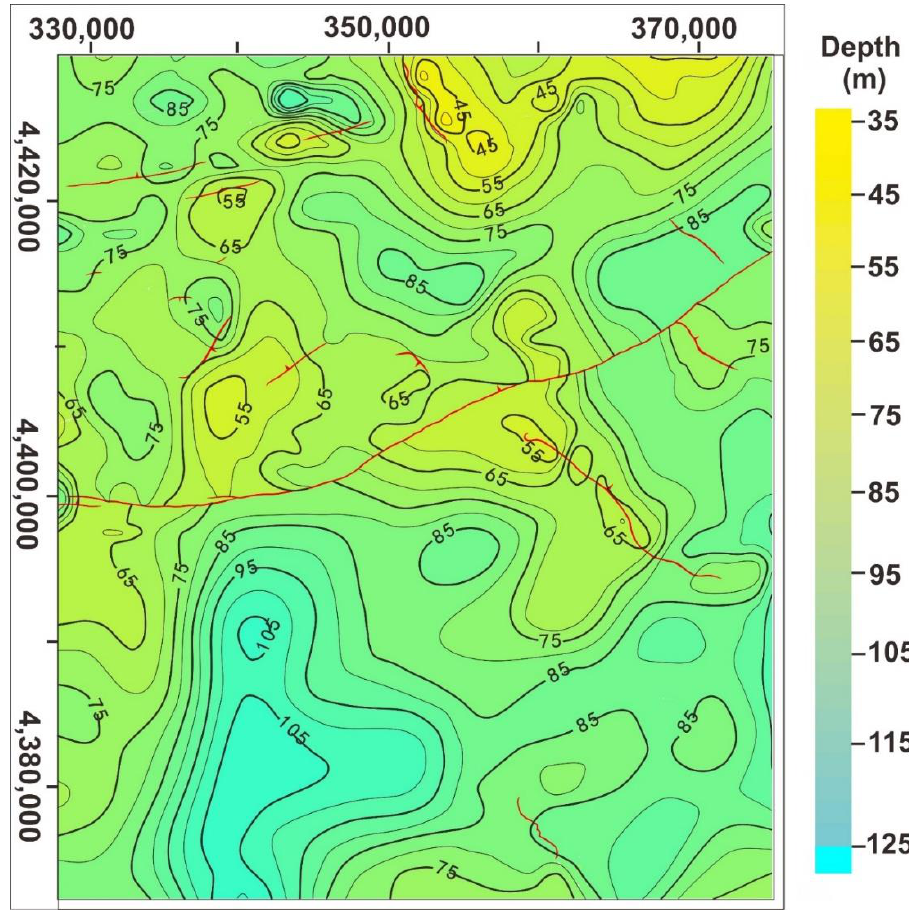
Figure 10. Thickness map of member-1 of LSF showcasing the faults distribution and contour values along with targeted horizon slices of T9d-T9e.